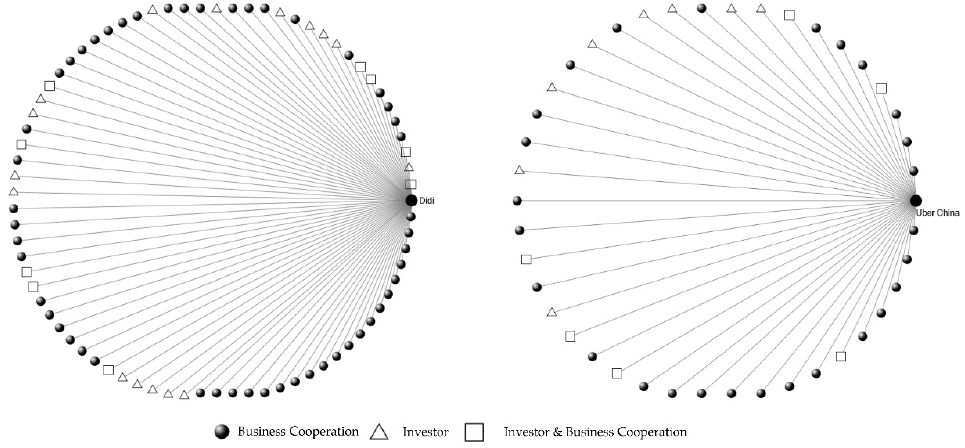
Figure 7. Partnership structure comparisons between DiDi and Uber China.